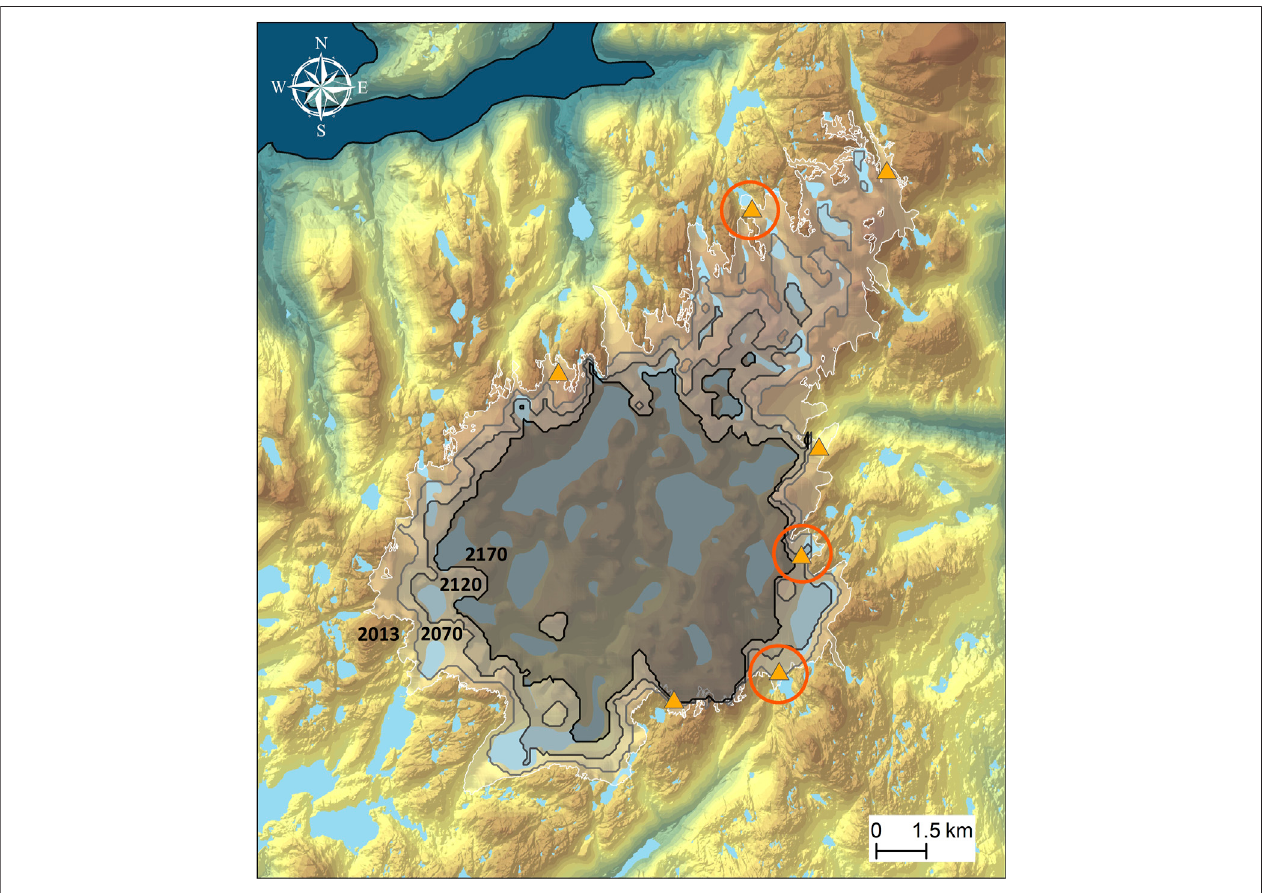
FIGURE 11 | The interpolated subglacial landscape of Sørfonna is overlain by today ’ s glacial extent (white/transparent; 2013) to identify possible locations of GLOFs. The orange triangles represent locations where a GLOF has occurred or where a GLOF is likely to occur, according to NVE. The orange circles mark current GLOF-marked siteswithan over-deepening behind the present (2013) glacialmargin. The different shades ofgray represent theice cap under climatescenario1for the years 2070, 2120, and 2170. Notice the locations of overdeepenings (possible future lake location) where a future GLOF-site could appear.